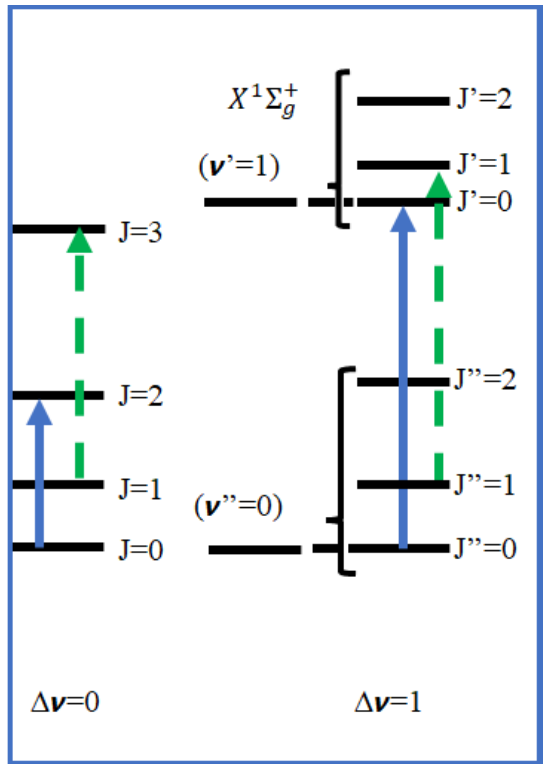
Fig. 13. Hydrogen Ro-Vibrational spectroscopy: energy levels and main rotational – vibrational lines. 4.1.1 MOF.